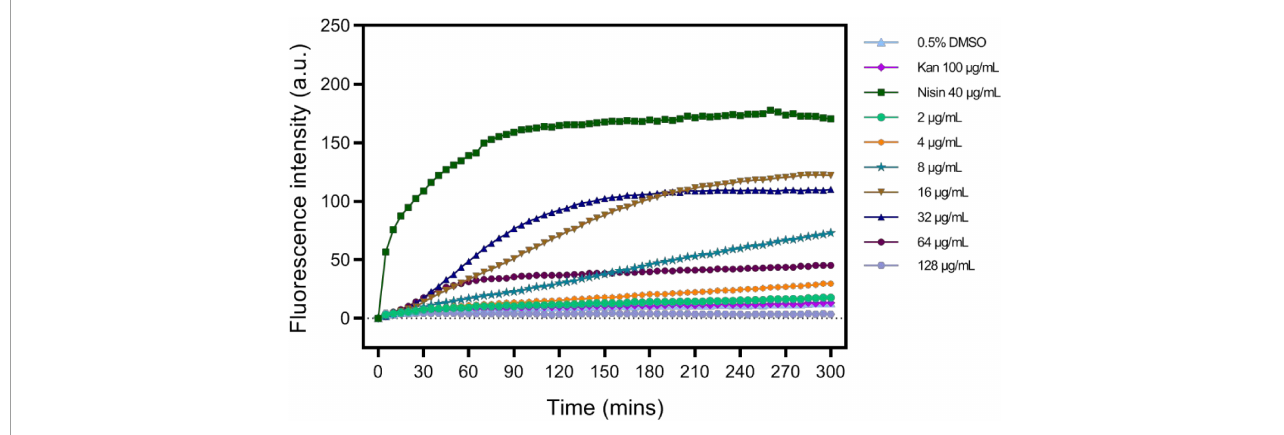
FIGURE8 S2303 triggers the Membrane permeability changes of Staphylococcus aureus BAA 41. S. aureus BAA 41 was treated with S2303 at different concentrations. Dimethyl sulfoxide (DMSO) and kanamycin treatment are regarded as the negative control, while Nisin treatment is regarded as the positive control. Fluorescence intensity stands for the amount of SYTOX that has entered cells and binds to the nucleoid. Fluorescence intensity was measured by TECAN automated liquid handling system freedom EVO 100.